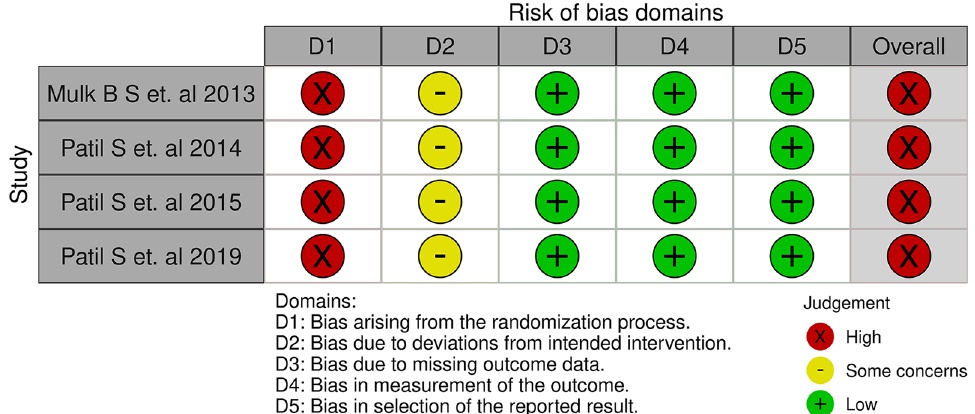
Fig. 2. Risk of bias assessment for randomized controlled trial done by Revised Cochrane risk-of-bias tool for randomized trials (RoB 2) tool.